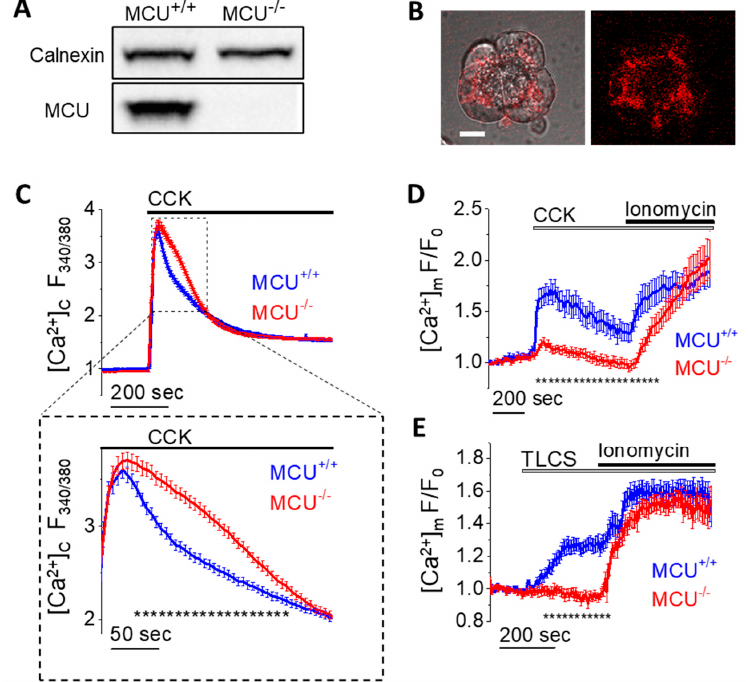
Figure 1. Cytosolic and mitochondrial Ca 2+ signaling in pancreatic acinar cells from MCU − / − and WT (MCU +/+ ) mice. ( A ) Western blot analysis of MCU in pancreata isolated from MCU − / − and MCU +/+ mice. The complete Western blot associated with this figure is shown in Figure S1A. ( B ) Images of MtRCaMP in a small cluster of WT pancreatic acinar cells showing a typical mitochondrial distribution (e.g., [11] ). The right panel shows the distribution of fluorescence. The left panel shows the overlay of transmitted light and fluorescence. Scale bar represents 10 μ m. A similar distribution was observed in the acinar cells from MCU − / − mice (Figure S1B). ( C ) [Ca 2+ ] C responses (measured with fura-2 (loaded in fura-2 AM form), 340 nm:380 nm ratio) to 1 nM CCK in pancreatic acinar cells isolated from MCU − / − mice ( n = 286 cells, N = 4 mice) and MCU +/+ mice ( n = 197 cells, N = 4 mice). The expanded fragment (lower panel in (C)) highlights the period of [Ca 2+ ] C responses in which there were significant differences between measurements conducted on acinar cells isolated from MCU − / − mice and MCU +/+ mice. Dotted line under the traces (composed of small asterisks) indicates the only period (from 55 to 215 s following CCK addition) when the measurements from MCU +/+ and MCU − / − cells were significantly different ( p < 0.05). Here and in (D–E) data are presented as the mean value ± standard error of the mean. ( D ) [Ca 2+ ]m responses to 1nM CCK followed by 20 μ M Ionomycin/10 mM Ca 2+ in pancreatic acinar cells isolated from MCU − / − mice ( n = 53 cells, N = 5 mice) and MCU +/+ mice ( n = 25 cells, N = 3 mice). Here and in (E) the traces show the fluorescence of MtRCaMP (F) normalized to its initial fluorescence (F 0 ). Dotted line under the traces (composed of small asterisks) indicates the period (from 15 to 795 s following CCK addition) when the measurements from MCU +/+ and MCU − / − cells were significantly different ( p < 0.05). ( E ) [Ca 2+ ]m responses to 500 μ M TLCS followed by 20 μ M Ionomycin/10 mM CaCl 2 in pancreatic acinar cells isolated from MCU − / − mice ( n = 25 cells, N = 3 mice) and MCU +/+ mice ( n = 22 cells, N = 3 mice). Dotted line under the traces (composed of small asterisks) indicates the period (from 77 to 320 s following TLCS addition) when the measurements from MCU +/+ and MCU − / − cells were significantly different ( p < 0.05).